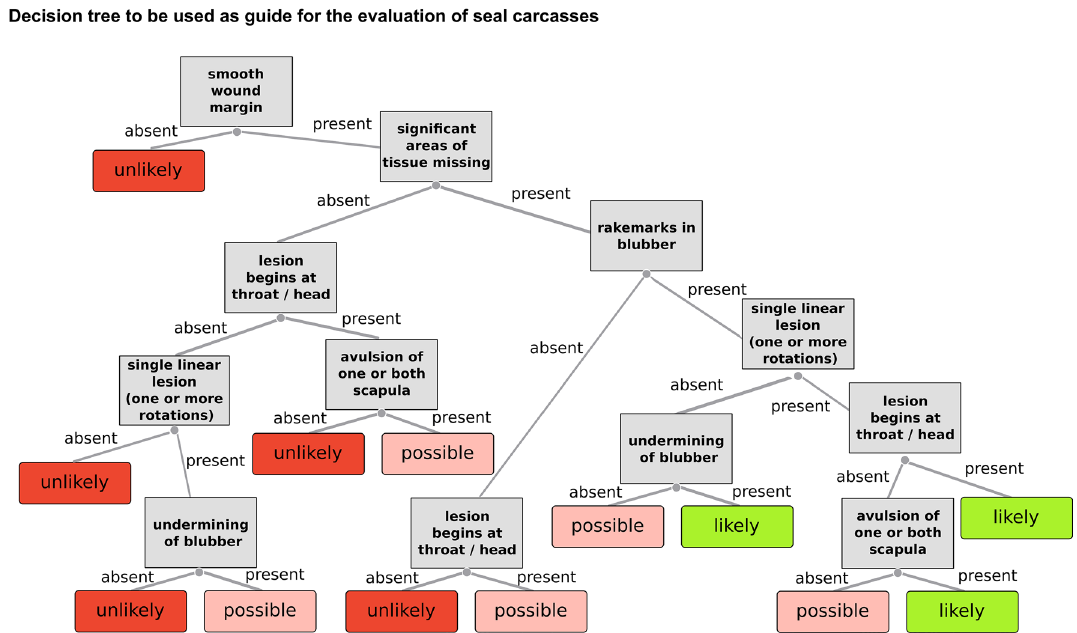
Figure 3. Decision tree developed using the occurrence and combination of detected lesions in seal carcasses. Resulting categories indicate the likelihood that the detected lesions are the result of grey seal